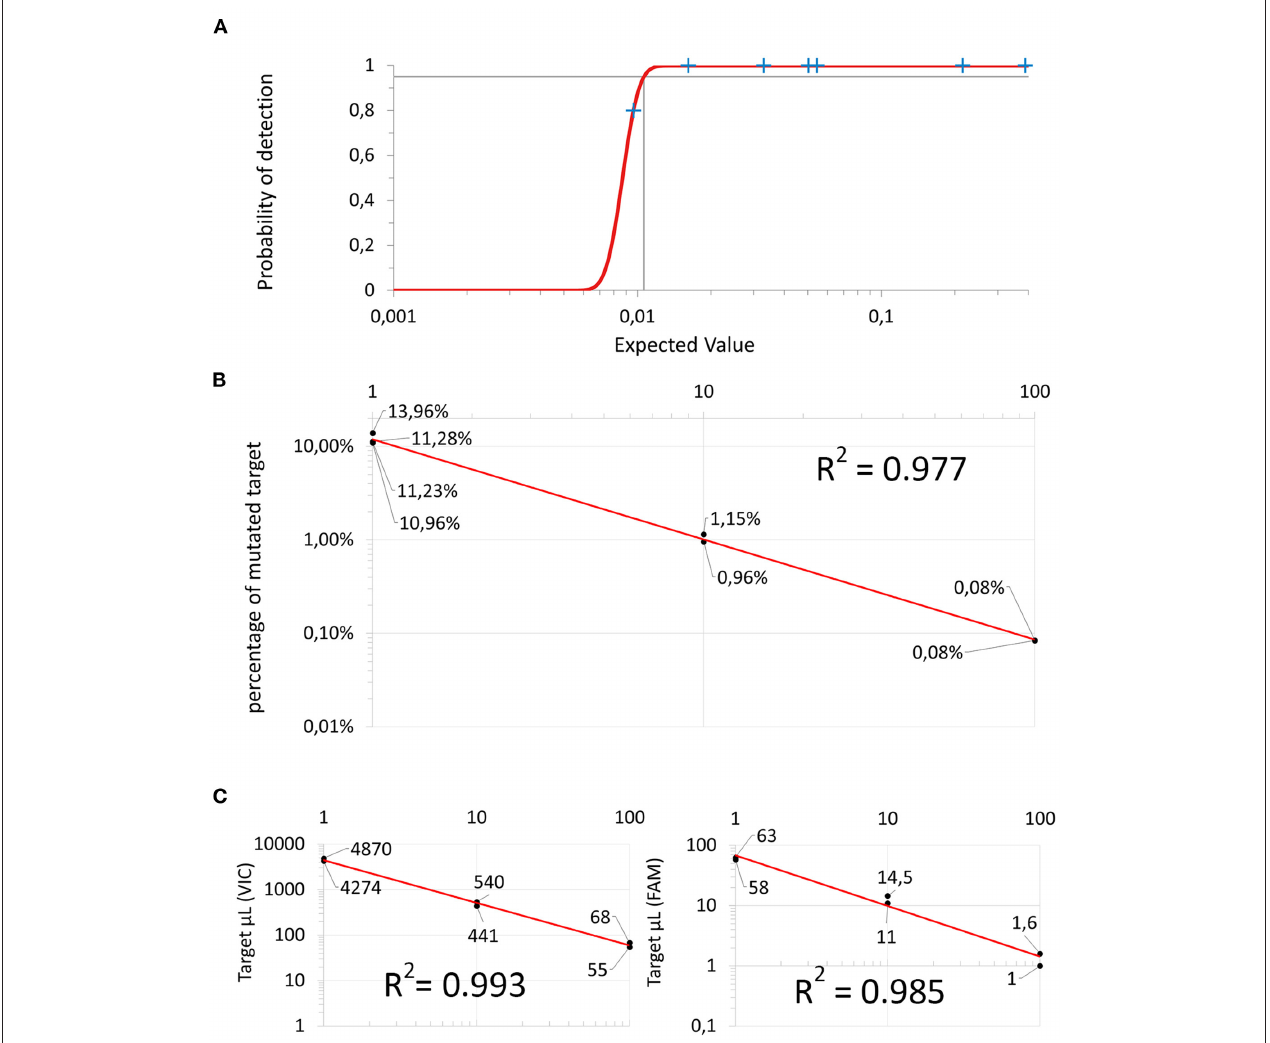
FIGURE 3 | Dilution experiments: (A) Probit regression curve used to infer the Limit of Detection. (B) 1:10 serial dilution using a sample containing only wild-type “target VIC” to dilute mutated “target FAM”. (C) 1:10 serial dilution using molecular biology grade water. Both the wild-type “target VIC” on the left and the mutated “target FAM” (on the right) are linearly diluted. The X-axis represents the dilution factor and the y-axis represents the absolute amount of copies/ µ L of target.